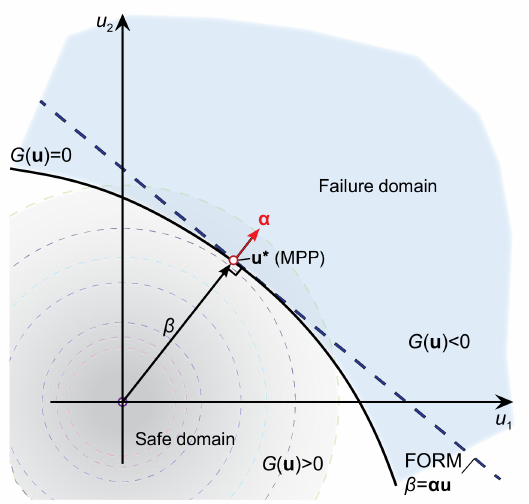
Figure 1. Illustration of the first-order reliability method (FORM) for a component reliability